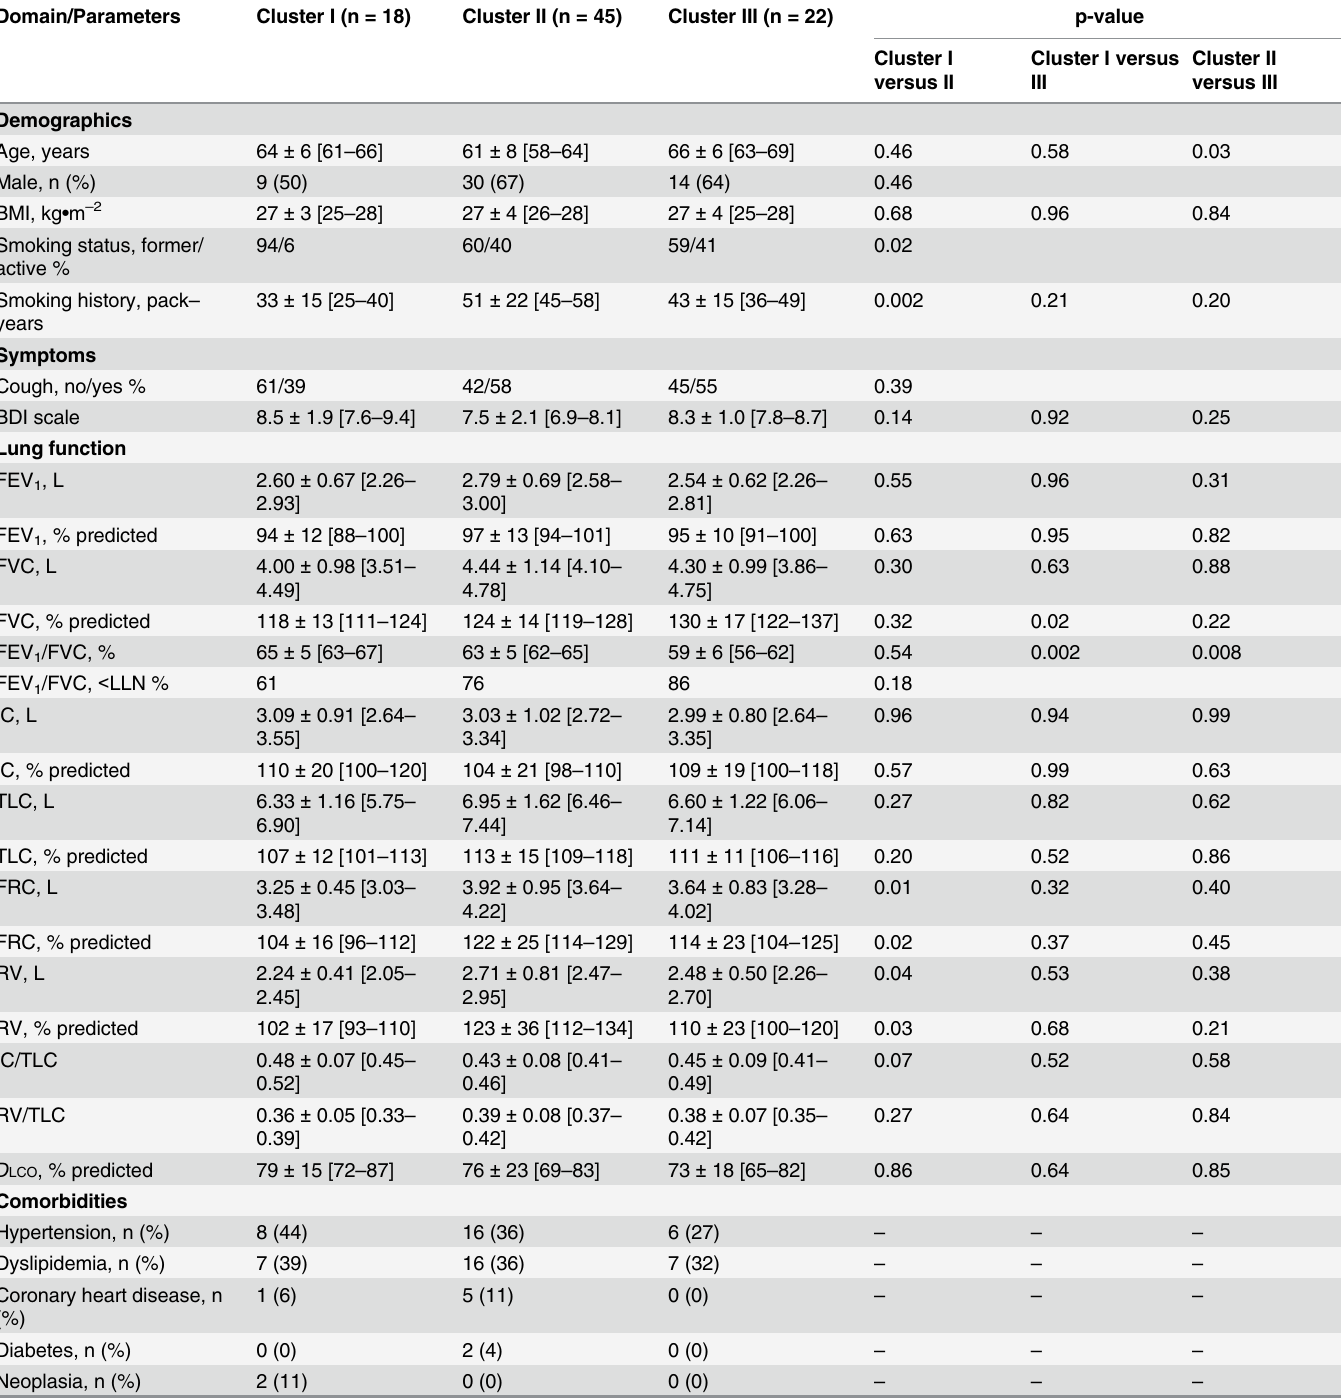
Table 2. Characteristics of patients with GOLD grade 1 COPD by